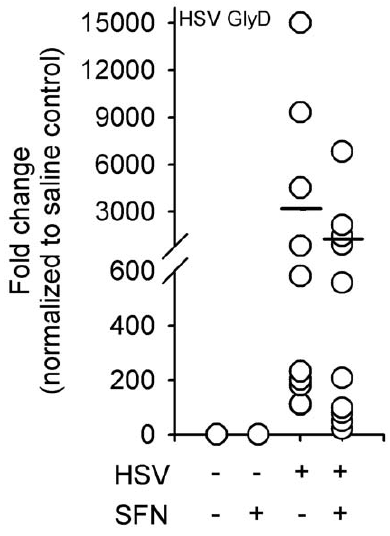
Figure 7. Sulforaphane does not affect establishment of HSV brain infection. Balb/c mice were infected with HSV-1 and given four 100 m l doses of SFN (50 mg/kg) or saline between 3–6 d p.i.. At 7 d p.i. subcortical tissue was collected, mRNA extracted and cDNA synthesized for semi-quantitative RT-PCR of HSV-1 glycoprotein D expression.